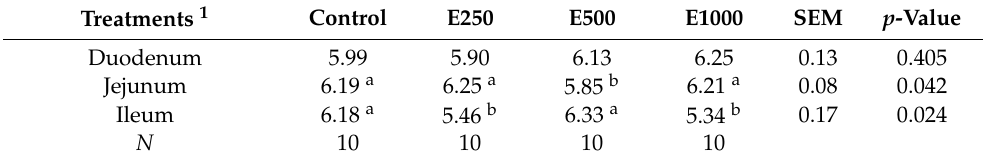
Table 5. Effect of glucose oxidase addition on the pH of intestinal digesta of broilers at 42 days of age. Treatments 1